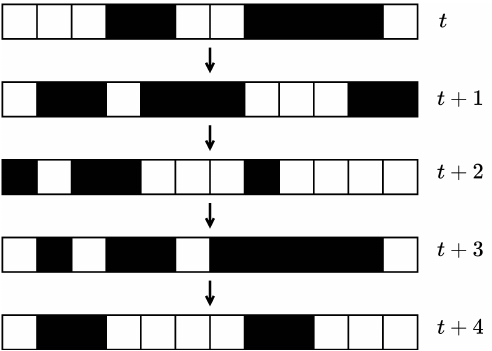
Figure 10. An example of five cycles of a one-dimensional PQCA. (Note: the colours of the squares stand for the measured values of the automaton. A black cell represents the number 1 and a white one the number 0.)